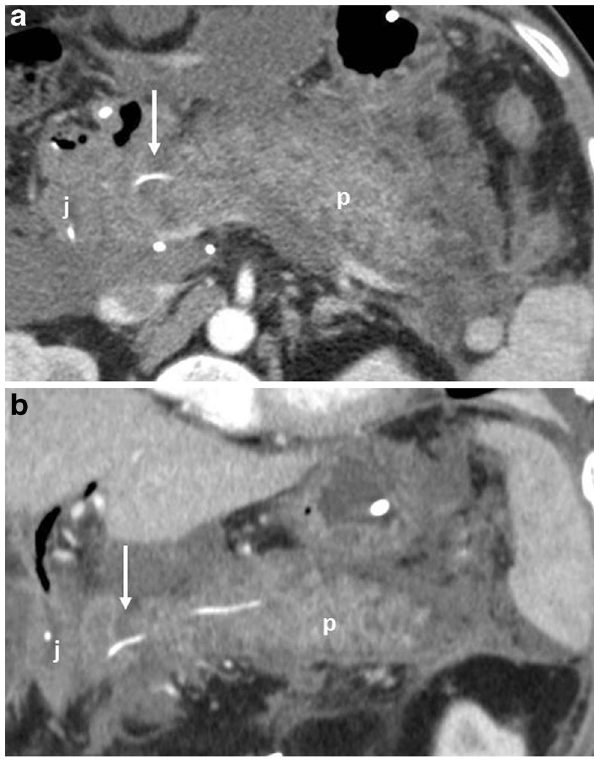
Fig. 21 Acute pancreatitis. a , b The pancreatic remnant (p), jejunal loop (j) and pancreatic anastomosis (white arrow) are visible. The pancreas is thickened and oedematous, surrounded by a discrete amount of fluid that extends along the anterior pararenal fascia, findings highly suggestive of an acute necrotic postoperative pancreatitis